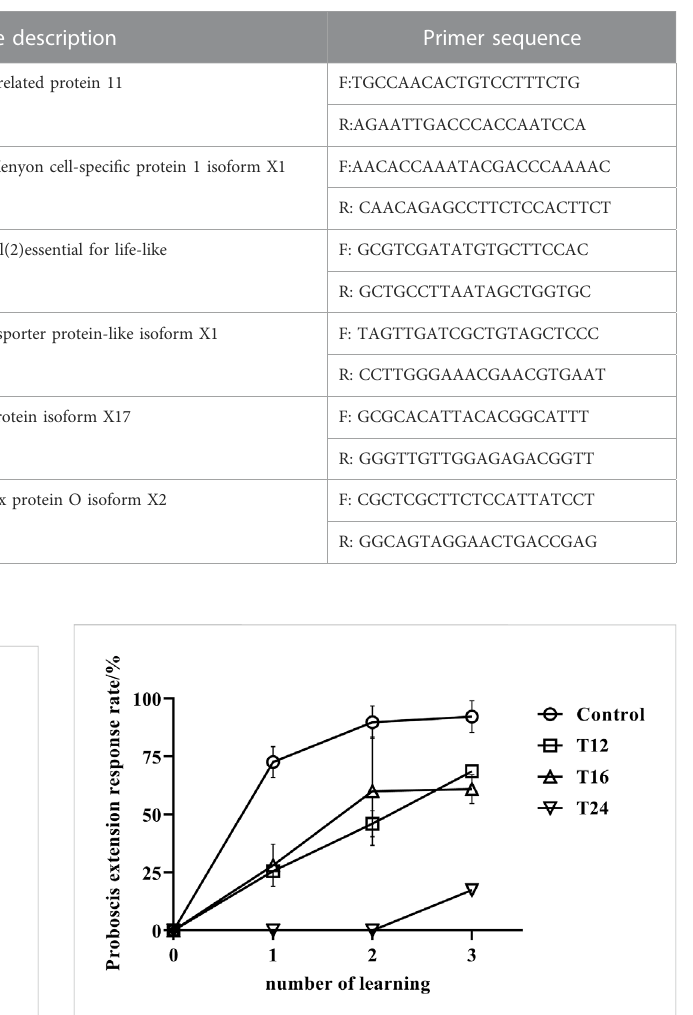
TABLE 1 Primers for qPCR of DEGs.